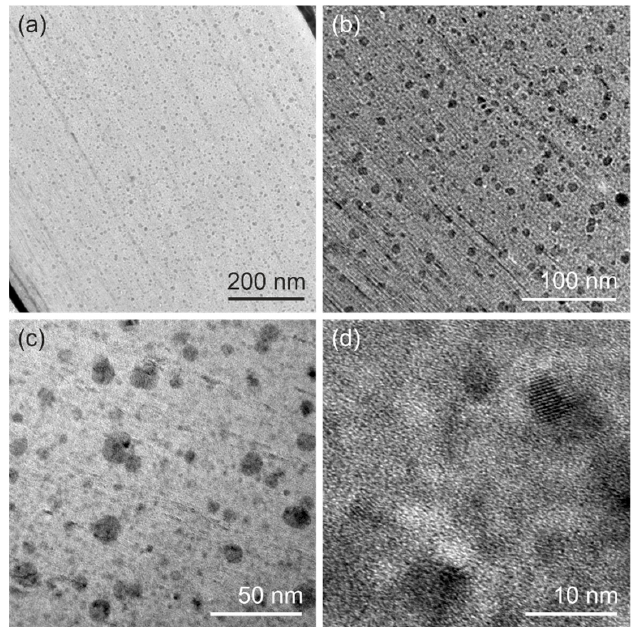
Figure 4. Images obtained during ex ‐ situ TEM investigation of the cross ‐ section of a cathode